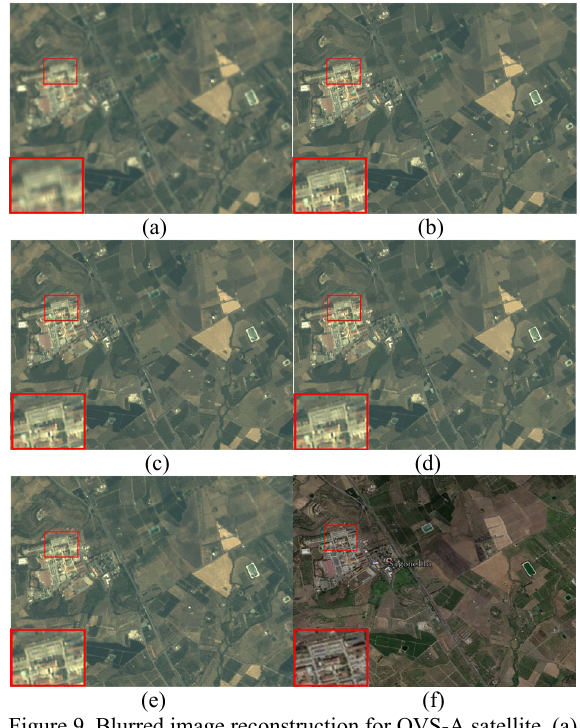
Figure 9. Blurred image reconstruction for OVS-A satellite. (a) input image. The reconstruction results of: (b) DCP, (c) ECP, (d)